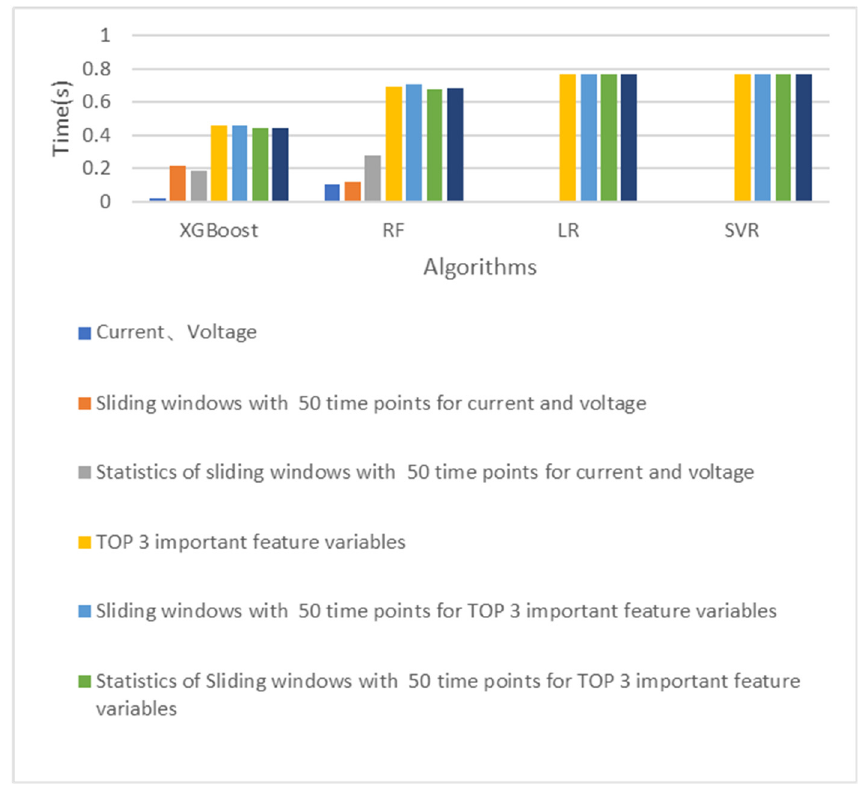
Figure 8. Total time consumption comparison of integrated algorithms for test set data (time within 0.8 s).